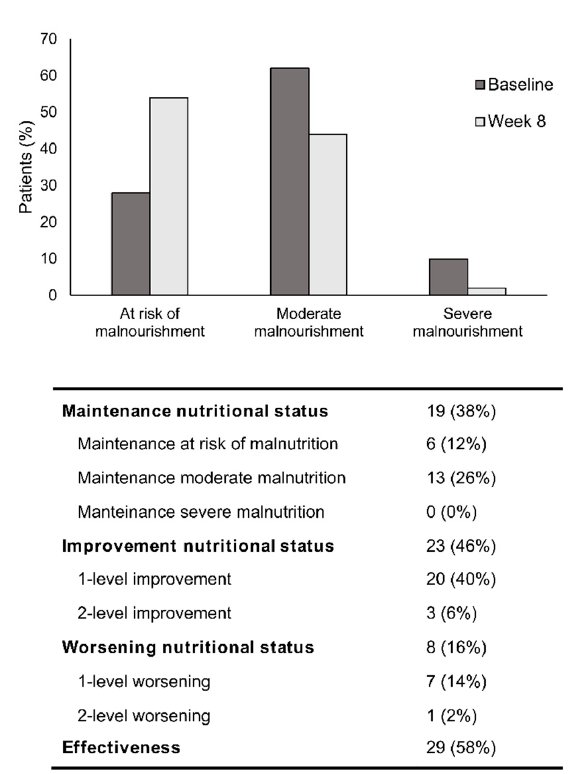
Figure 5. Nutritional status evolution in those 50 patients who did not improve diarrhea after 8 weeks of oligomeric enteral nutrition (OEN). The graph shows the proportion of patients at risk of malnourishment, with moderate or severe malnourishment at baseline and after 8 weeks of nutritional support with OEN. The table shows the proportion of patients with changes in the nutritional status and the effectiveness of the OEN protocol in improving the nutritional status in patients with persistent diarrhea.